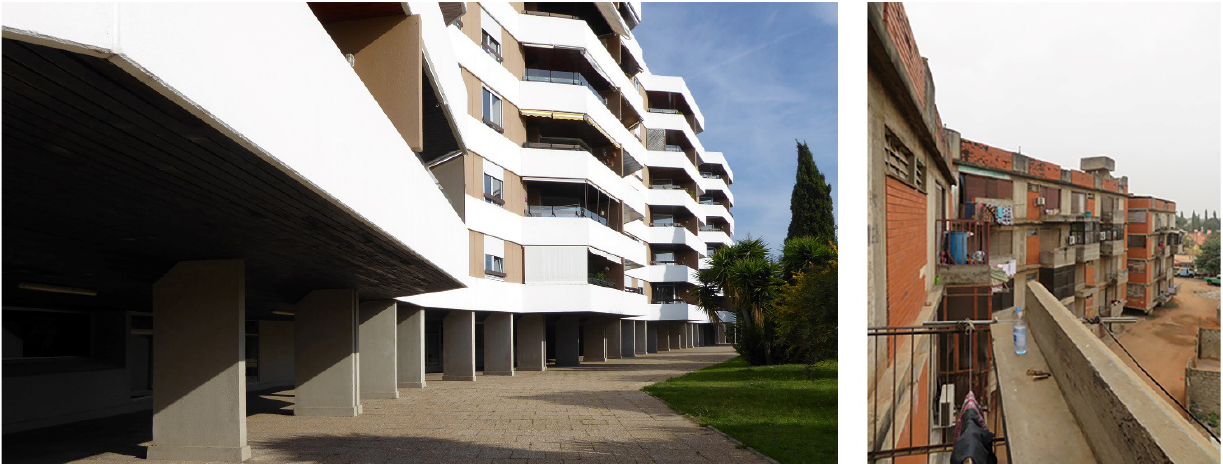
Figure 8. Undulating façades: Alto da Barra Complex (left) and CTT block (right). Sources: Photo taken by the author in 2019 (left) and courtesy of Ana Vaz Milheiro (right).